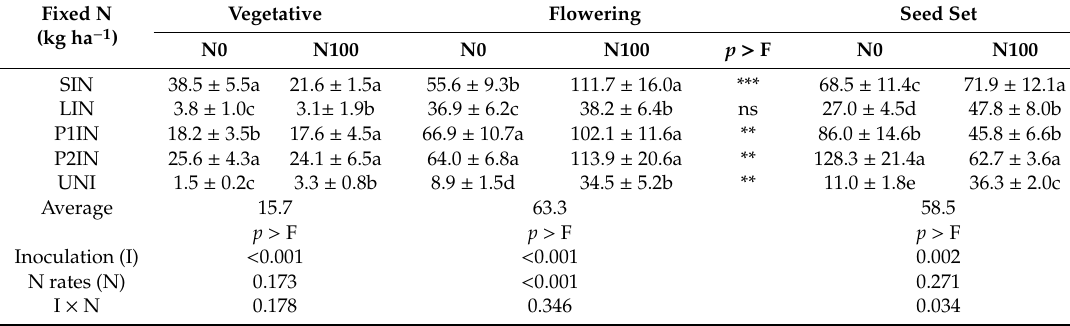
Table 7. Average ( ± standard error) fixed N in sulla leaves (kg ha − 1